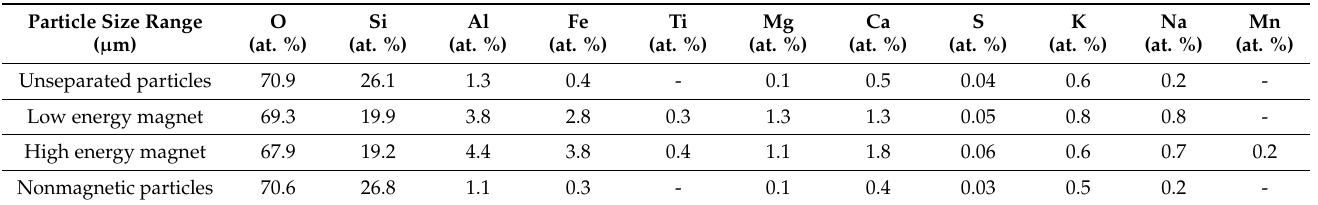
Table 2. Average mineralogical analysis of 200–400 μ m particle size range by magnetic separation with low and high energy magnet.